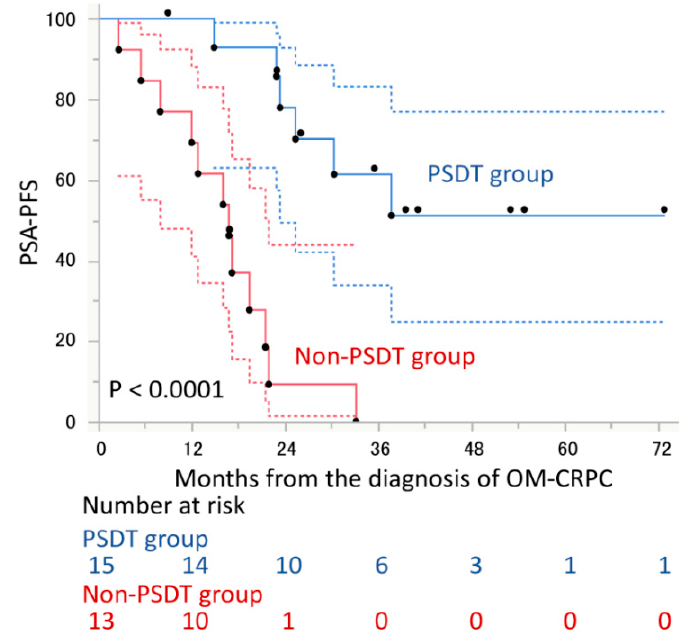
Figure 3. PSA progression-free survival (PSA-PFS) from the diagnosis of oligometastatic castration- resistant prostate cancer (OM-CRPC) stratified by performance of progressive site-directed therapy (PSDT). The 95% intervals calculated for each time point are shown as dashed lines.